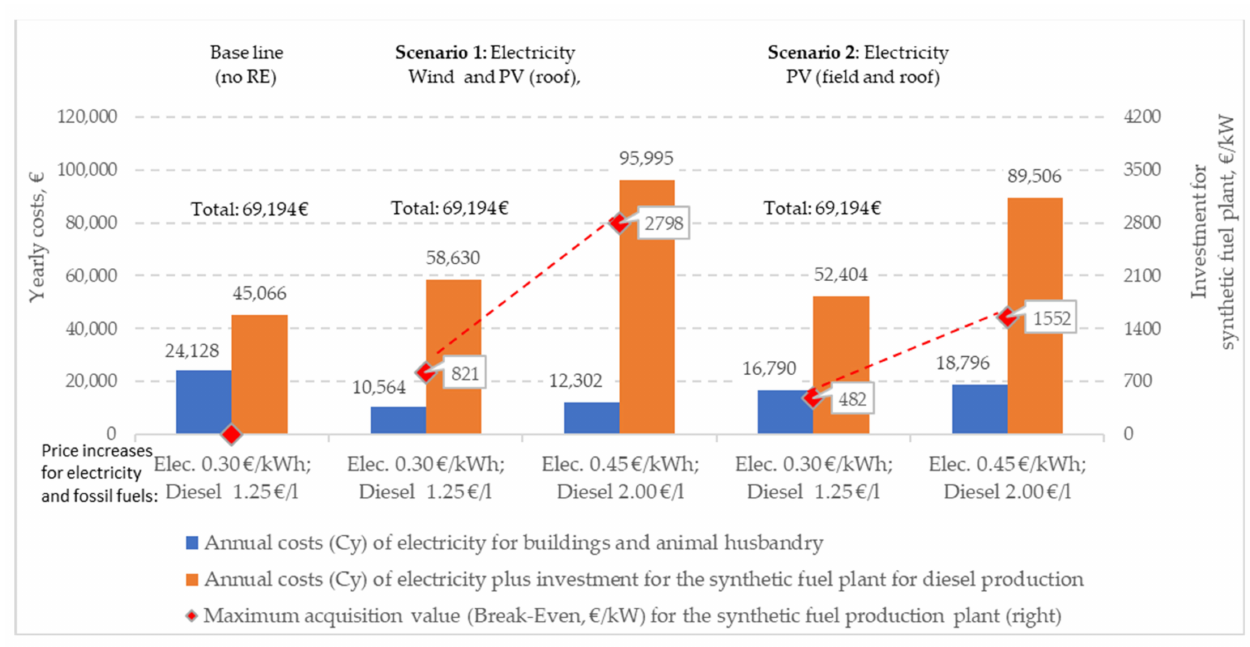
Figure 8. Annual costs for providing electricity to the barn and for producing synthetic fuel, com- paring baseline, Scenario 1 and 2 (according to Equations (6) and (7)) and the maximum acquisition values ( € /kW) for the synthetic fuel production plant to meet the total annual costs C y of the baseline